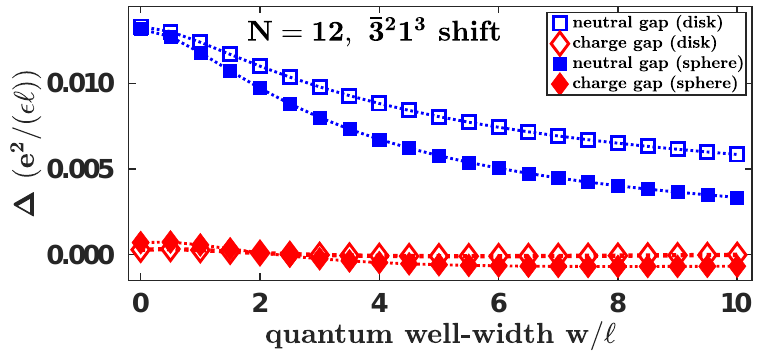
Figure 9: (color online) The second Landau level charge (red diamonds) and neutral (blue squares) gaps for N = 12 electrons at the shift corresponding to the ¯3 2 1 3 state at ν = 3 / 7 evaluated in the spherical geometry using the spherical (filled symbols) and disk pseudopotentials (open symbols) for various well-widths w